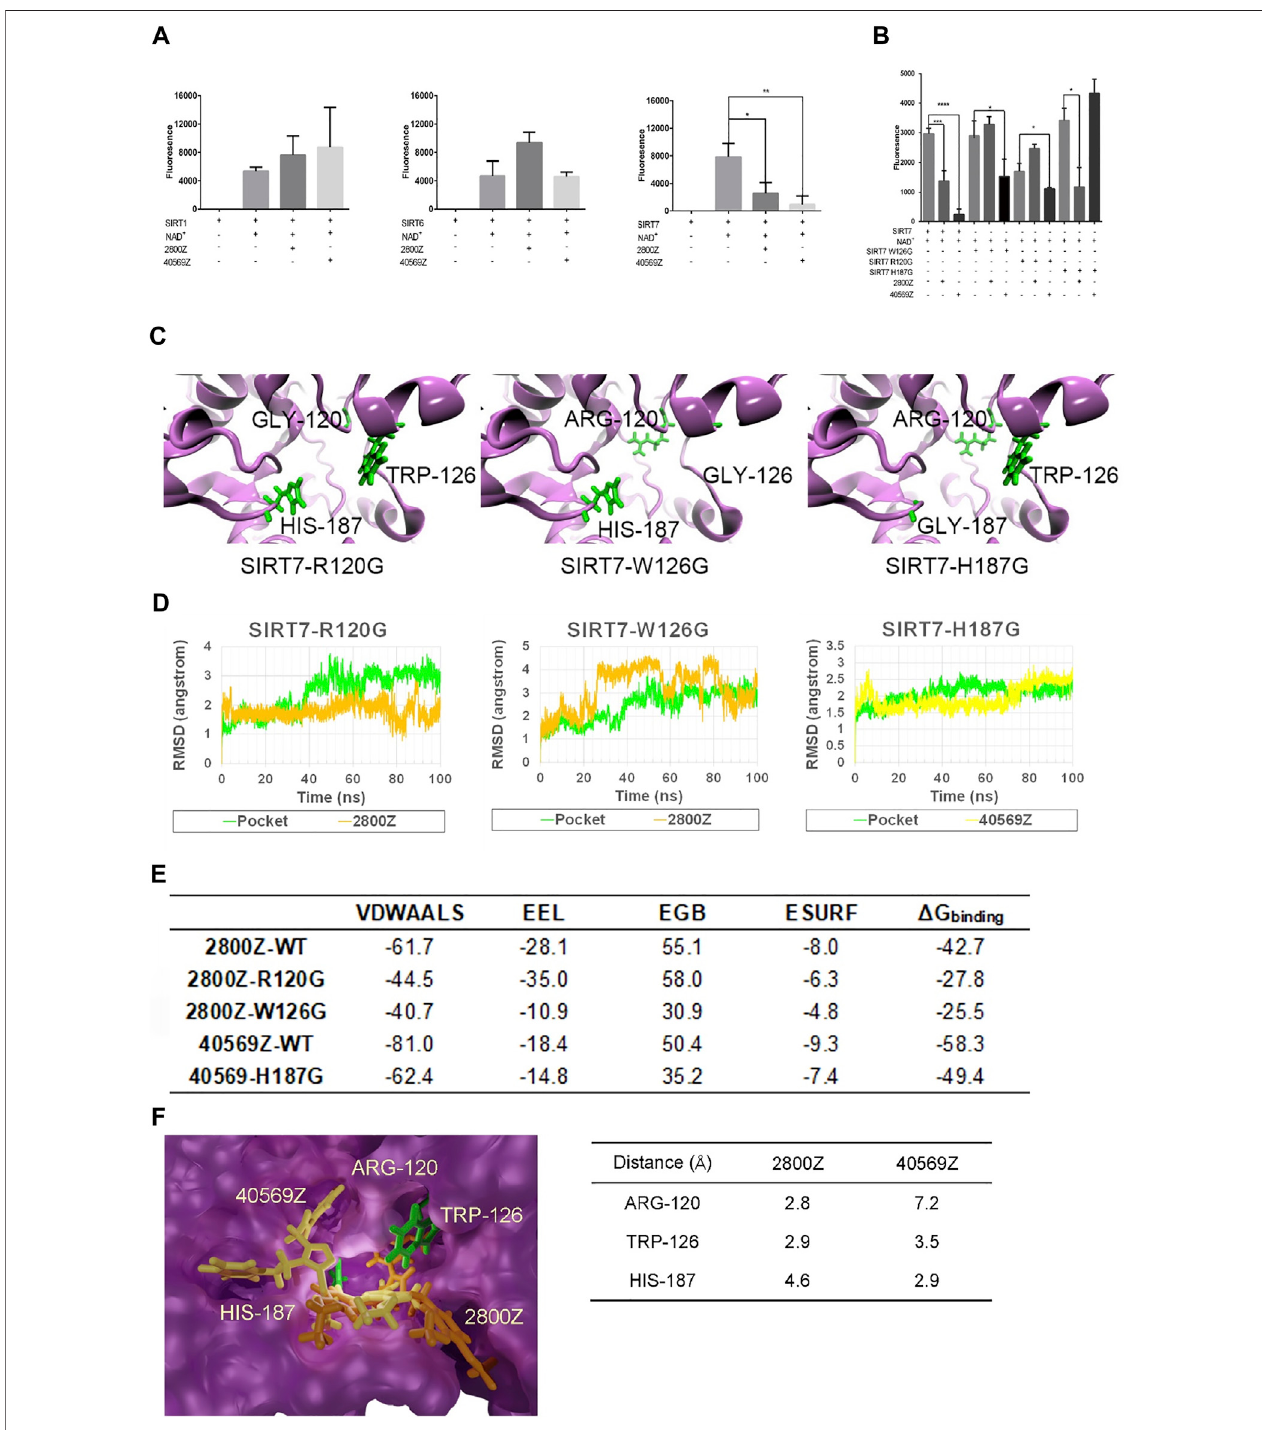
FIGURE 4 | 2800Z and 40569Z are the speci fi c inhibitors of SIRT7. (A) Flag tagged SIRT1, SIRT6, and SIRT7 were transfected with 293T cells for 24 h, and the proteins were puri fi ed by immunoprecipitation (IP), deacetylation activity of SIRT1, SIRT6, and SIRT7 was measured in the presence or absence of compounds 2800Z and 40569Z, respectively. * p < 0.05, ** p < 0.01 vs SIRT7+NAD + , one-way ANOVA. Graphs show mean ± SEM of at least three independent experiments. (B) Flag tagged SIRT7, SIRT7 R120G, SIRT7 W126G, and SIRT7 H187G were transfected with 293T cells for 24 h, and the proteins were puri fi ed by IP, deacetylation activity was measured in the presence or absence of compounds 2800Z and 40569Z. * p < 0.05*** p < 0.001, **** p < 0.0001, one-way ANOVA. Graphs show mean ± SEMofatleastthreeindependentexperiments. (C) SchematicstructureofSIRT7mutants:greensticksrepresentthekeyresidues. (D) RMSDforthreetypesofmutated complex. (E) Bindingfreeenergiesof2800Zand40569ZtoSIRT7andmutants(kcal/mol). (F) Diagramofthedifferentinteractionsof2800Zand40569ZtoSIRT7:green sticks indicate the key residues in protein – ligand interaction, yellow sticks represent 40569Z, and orange sticks represent 2800Z.